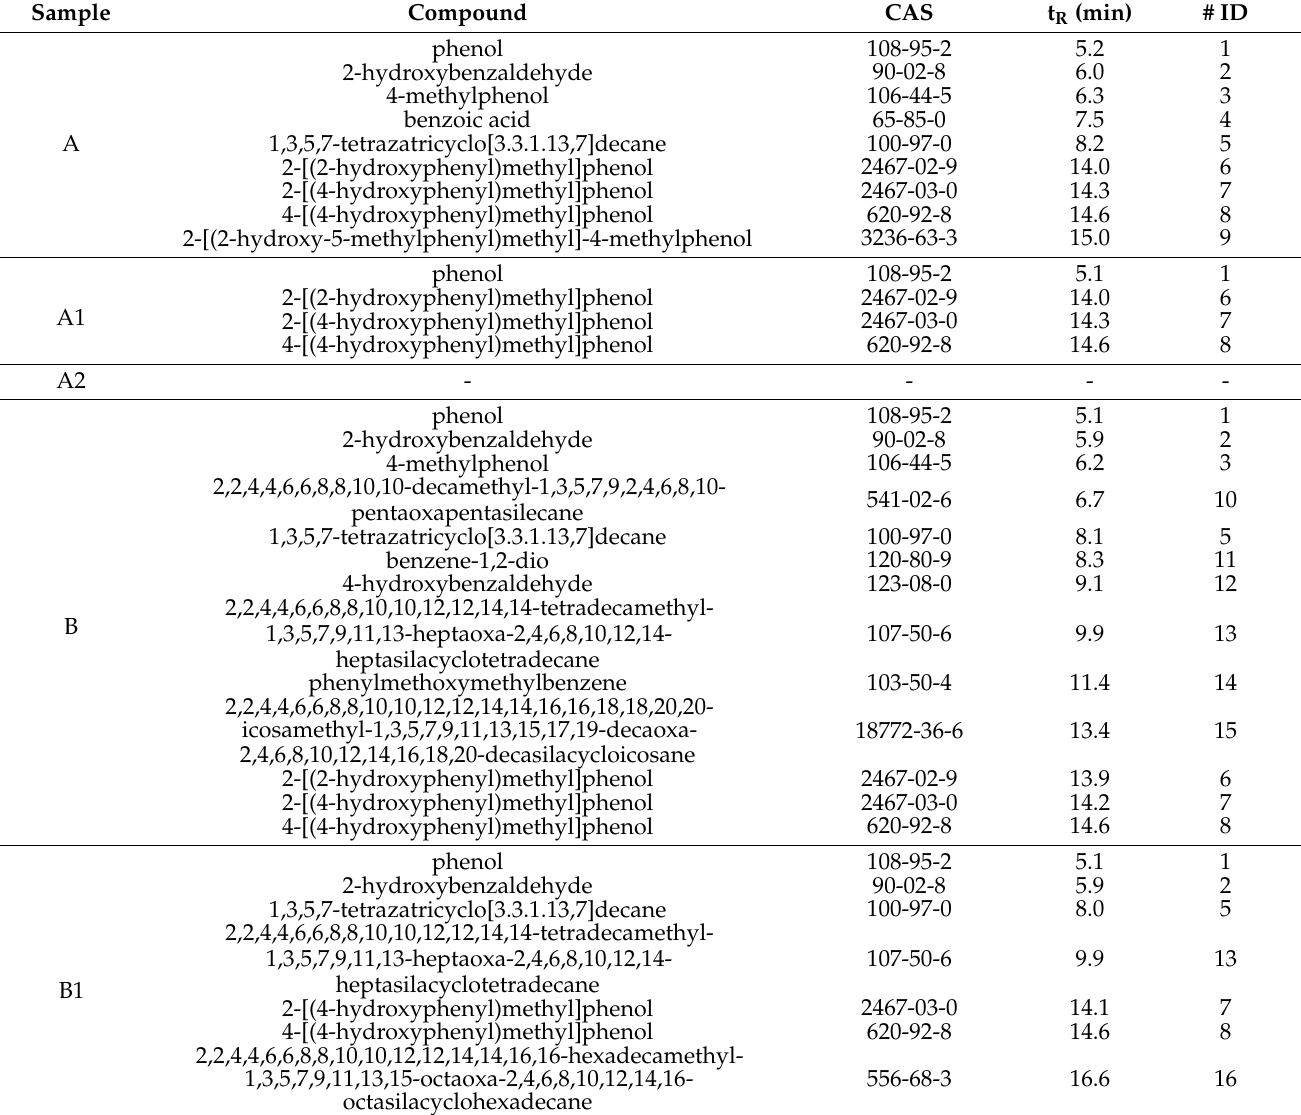
Table 3. Characteristic compounds in samples